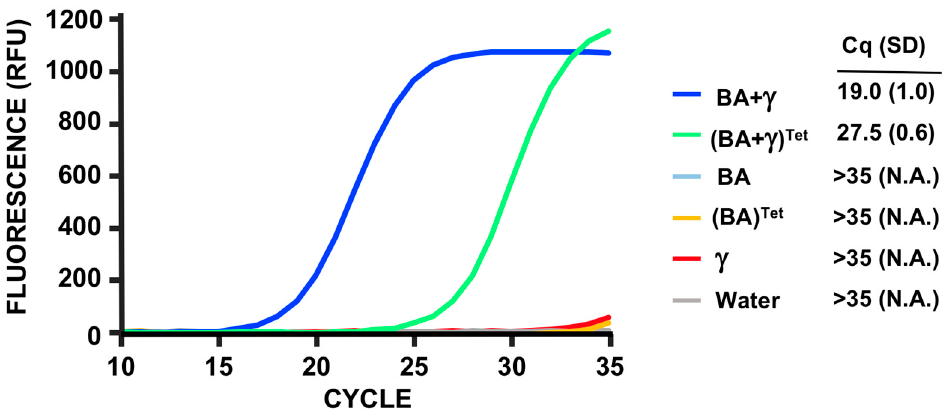
Figure 6. Fluorescent qPCR results of B. anthracis Sterne detected using phage Gamma RNA production. RNA levels from phage Gamma ( γ ), BA cells (BA), and BA cells infected with phage Gamma for 10 minutes (BA + γ ) were used for the assay (see text for details). Bacterial cultures grown in the presence of tetracycline (Tet) are indicated. The colored lines’ correspondence, relative fluorescent units (RFU), number of cycles, and Cq average and S.D. values of three biological replicates done in parallel are